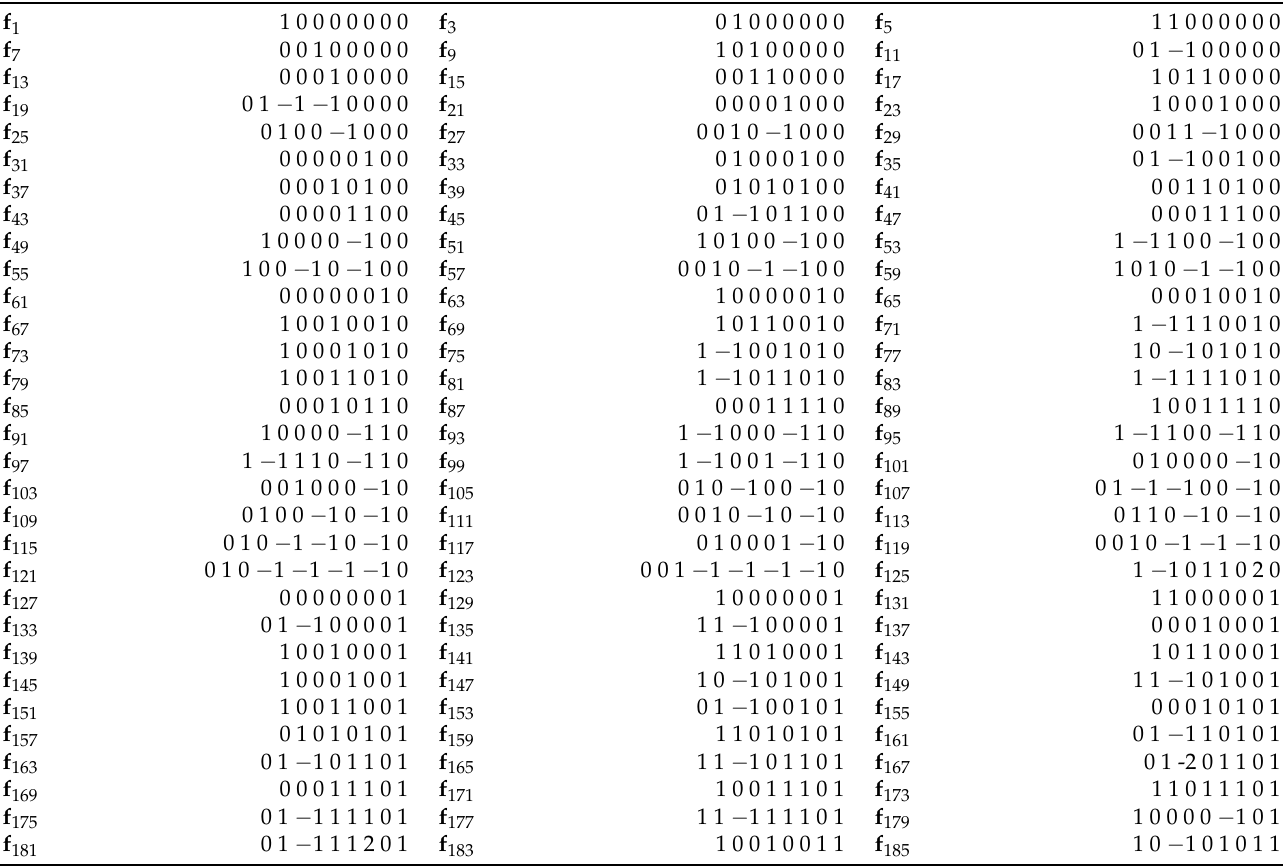
Table 2. The facet vectors ± f i of P ( Q E